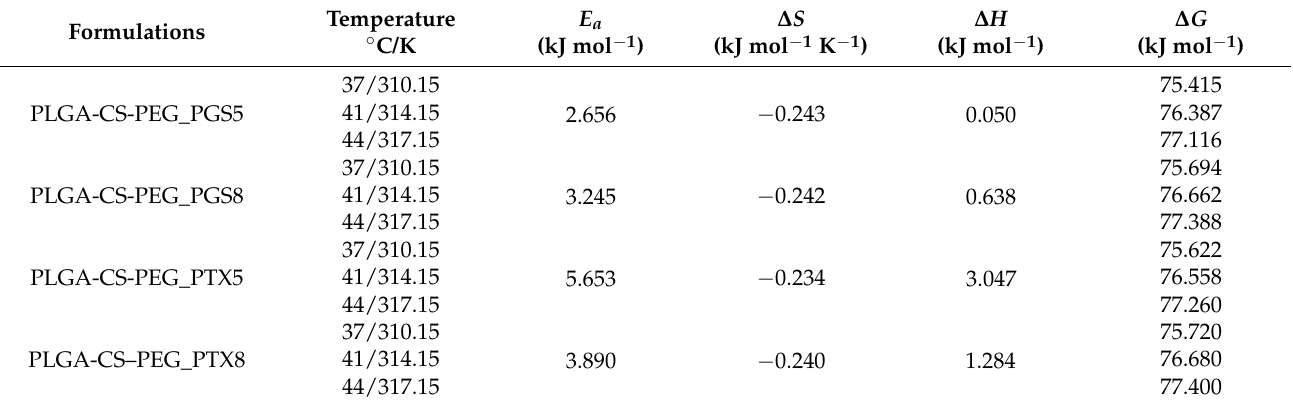
Table 5. Values for thermodynamic parameters for PLGA-CS-PEG microspheres.